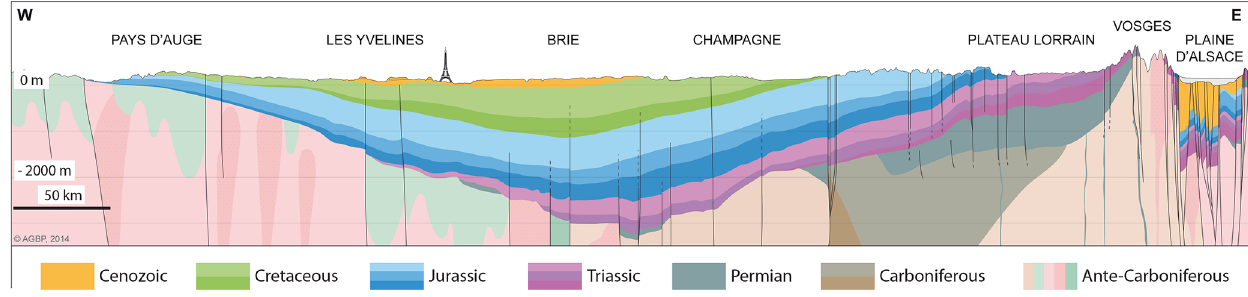
Figure 9. East–west transect through the Paris Basin.